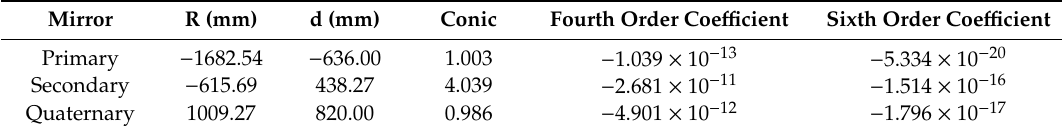
Table 8. Configuration parameters of the final o ff -axis four-mirror